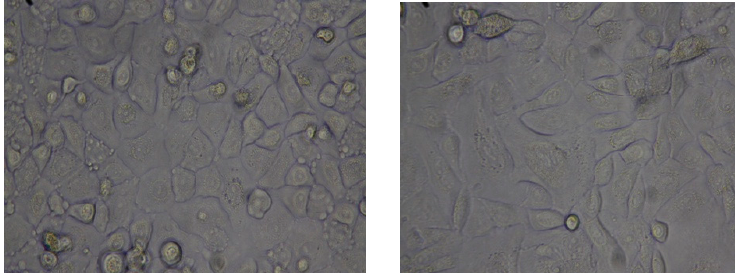
Figure 4. Light microscope images (20× and 40× magnification) of human OMECs after 1, 14 and 21 days of culture on 3-day old HA hydrogel scaffold mixture 5 coated with 1 mg/mL collagen IV. A 3-week culture of OMECs resulted in a full sheet of cells with morphological features resembling control cells. * Cultured human OMECs on coated plastic 24-well-plate with 1 mg/mL collagen IV.